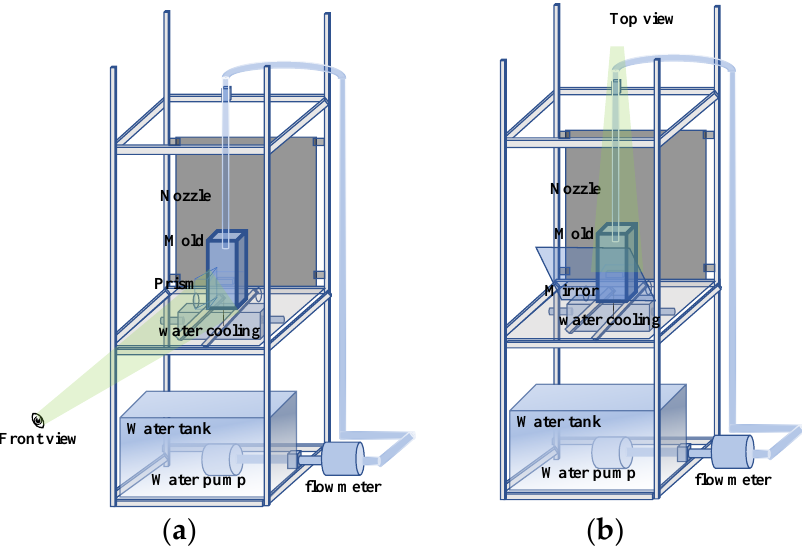
Figure 1. Experimental setting. ( a ) Front view and side view; ( b ) top view and front view. The flow field in three forms of hydraulic jump during the filling process is processed by open-source software PIVlab (PIVlab 2.53, William Thielicke, Hamburg, Germany). The flow field analysis area selected is rectangular in PIVlab. The selected area is divided into two areas by the fluctuating liquid surface: one part is liquid under the surface, and another is air above the surface. The area not analyzed is indicated by the red cross “ × ”; in the area analyzed, the velocity vector is indicated by the green arrow “ → ”. (Seen in Figures 2 and 4) In order to study the effect of solidification on the flow field, a water-cooling system is set at the mold bottom, and a sodium acetate solution is used to simulate the formation process of molten steel solidifying on the surface of the dummy bar. The specific steps are as